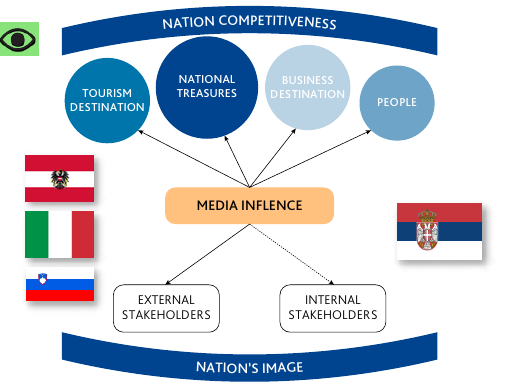
Figure 3: Nation branding model for